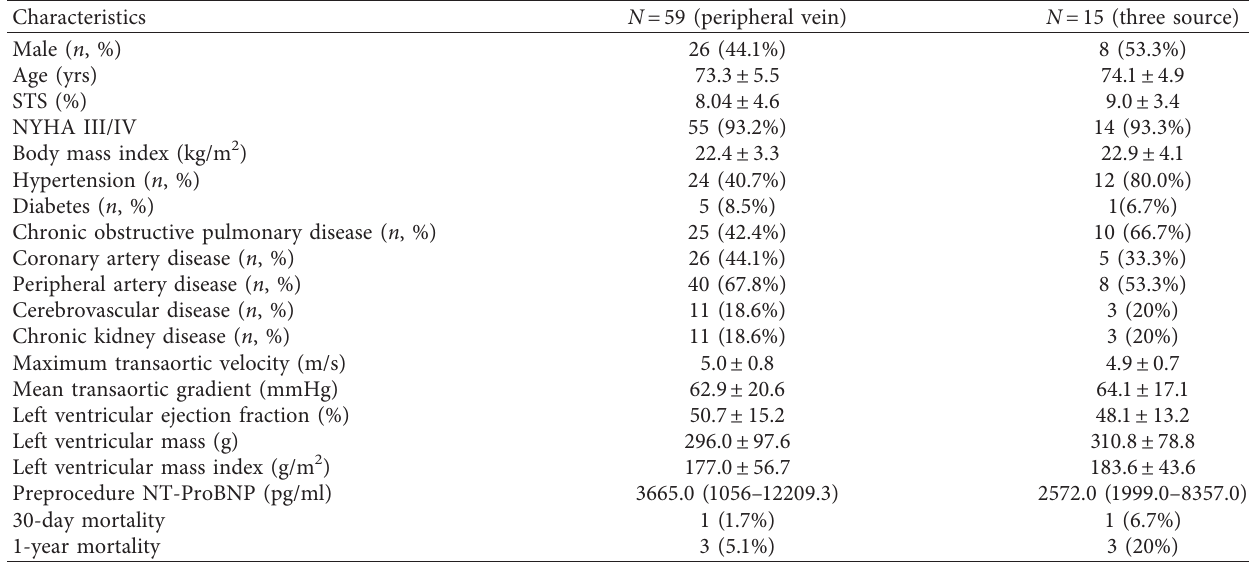
Table 1: Clinical characteristics of participants.